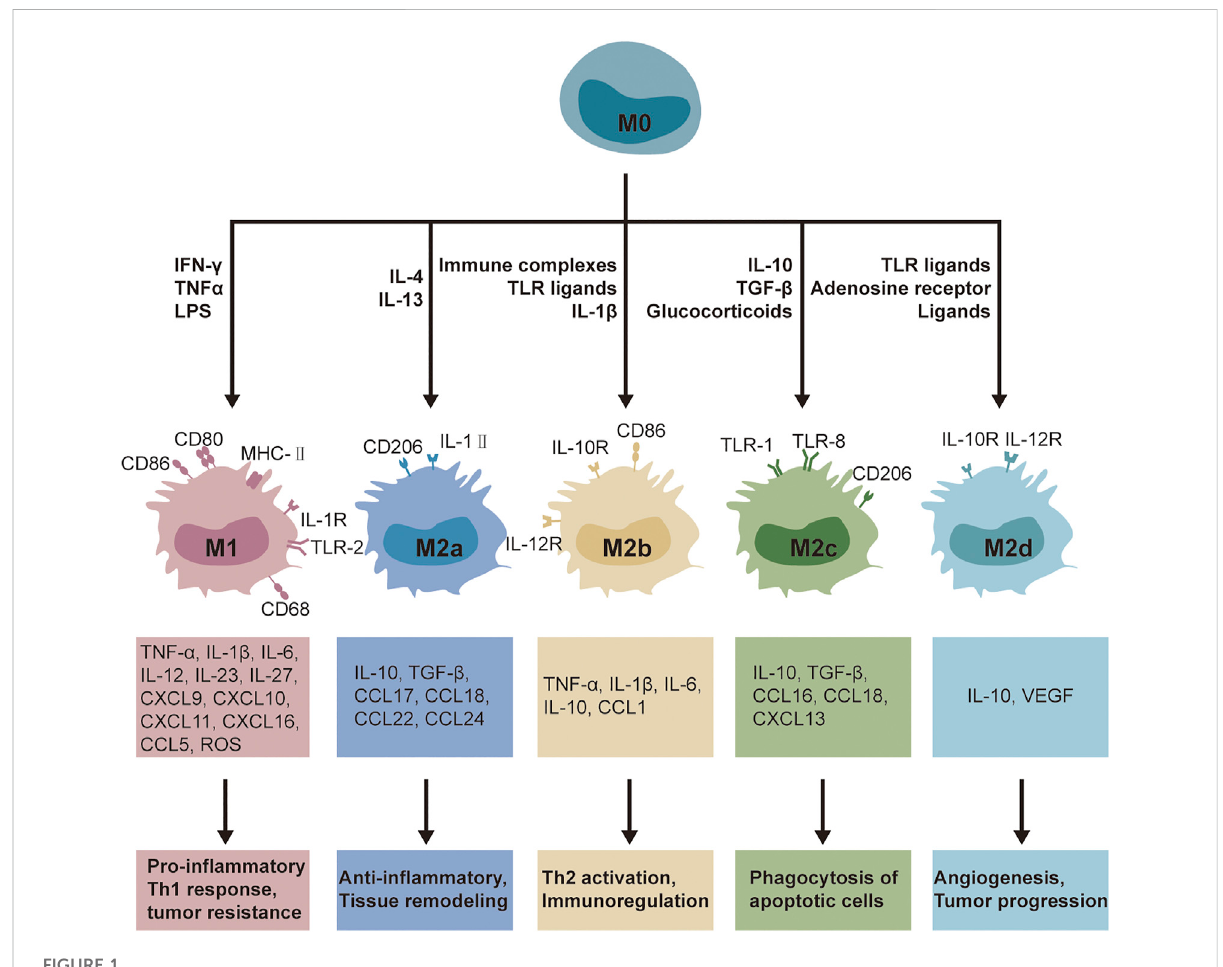
FIGURE 1 Overview of different biological and physiological features of macrophages